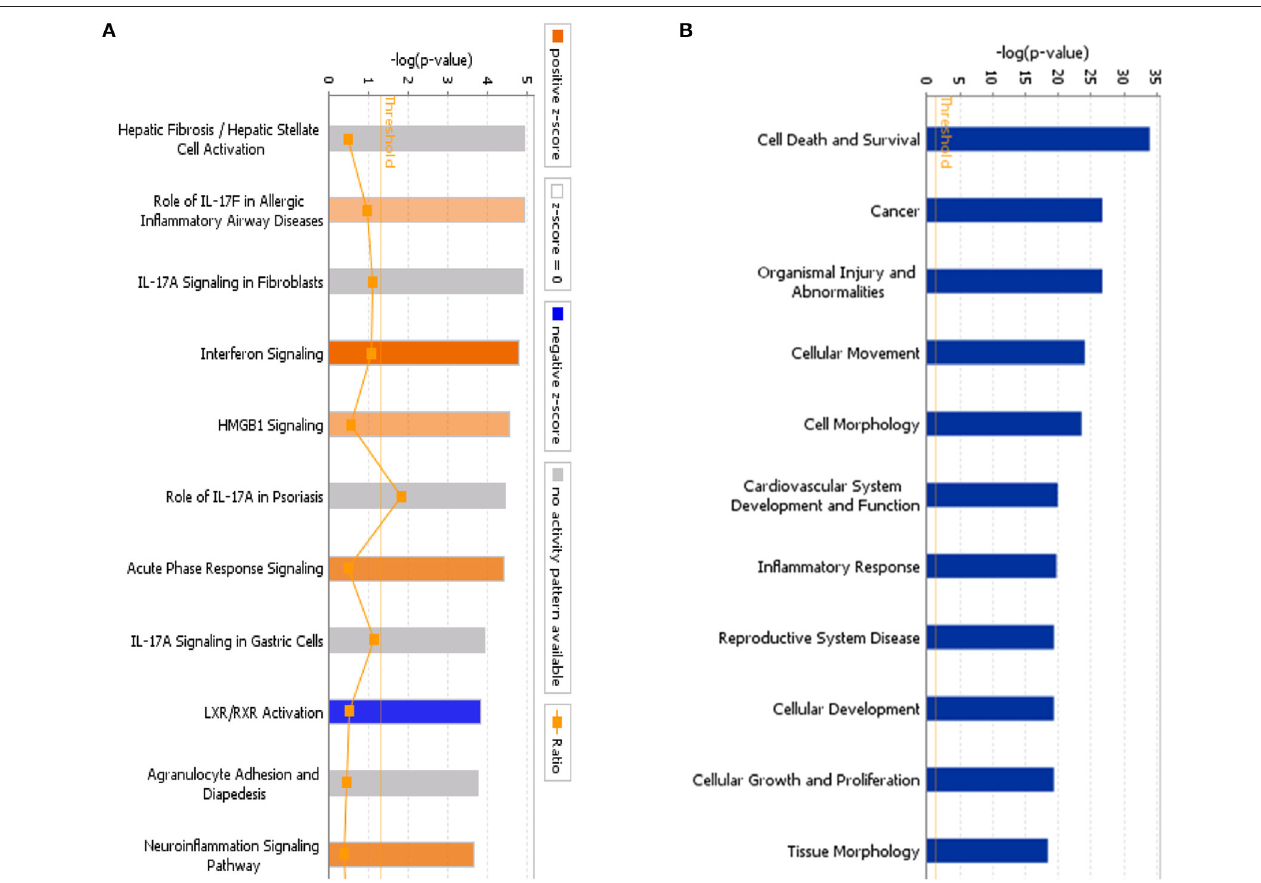
FIGURE 4 | (A) Classical pathway enrichment analysis. The orange label indicates pathway activation ( z -score > 0), the blue label indicates pathway suppression ( z -score < 0), and the shades of orange and blue indicate the degree of activation or inhibition (the absolute value of the z -score). The ratio represents the number of differentially expressed genes in this signaling pathway and the number of all genes in the pathway. (B) Disease and functional enrichment analysis statistics. This figure shows the differentially expressed genes in the IARS2-silenced cells that are significantly enriched in disease and function. The abscissa is the name of the path and the ordinate is the level of significance of the enrichment (the negative logarithm of the base 10).